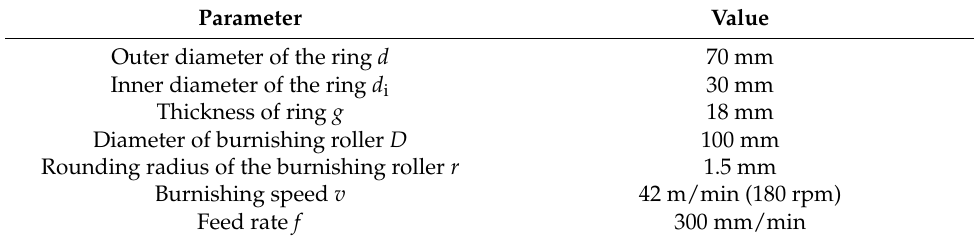
Table 3. Dimensions of samples and burnishing parameters.